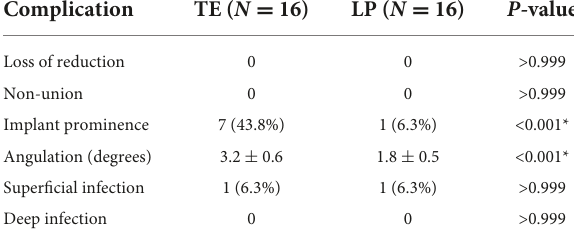
TABLE 3 Complications after